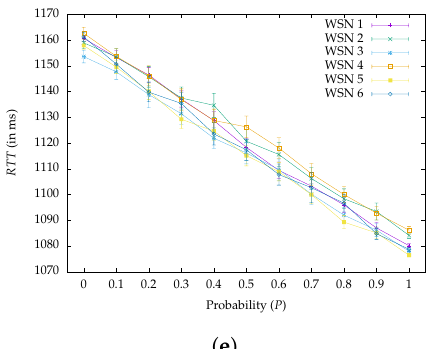
Figure 8. Experimental results regarding the mean RTT , through the scope of the deployed WSNs. The error bars refer to the upper and lower 95% confidence intervals. ( a ) Interval: 25,000 (in ms). ( b ) Interval: 20,000 (in ms). ( c ) Interval: 15,000 (in ms). ( d ) Interval: 10,000 (in ms). ( e ) Interval: 5000 (in